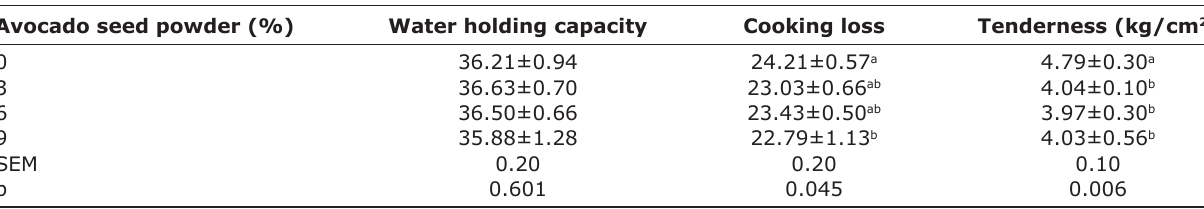
Table-5: The quality physical properties of meat. Avocado seed powder